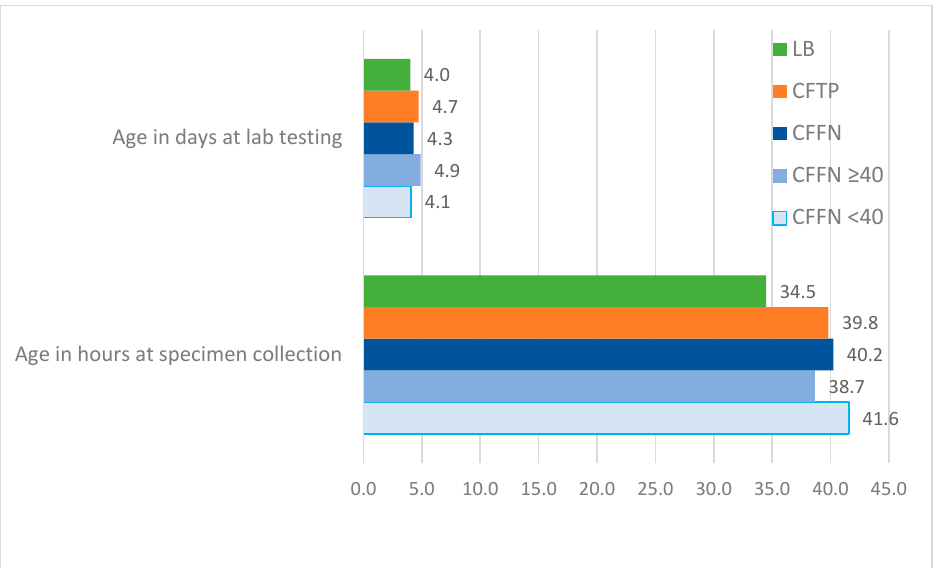
Figure 4. Weighted average median age at specimen collection and laboratory testing for all study groups in 6 one-specimen states.